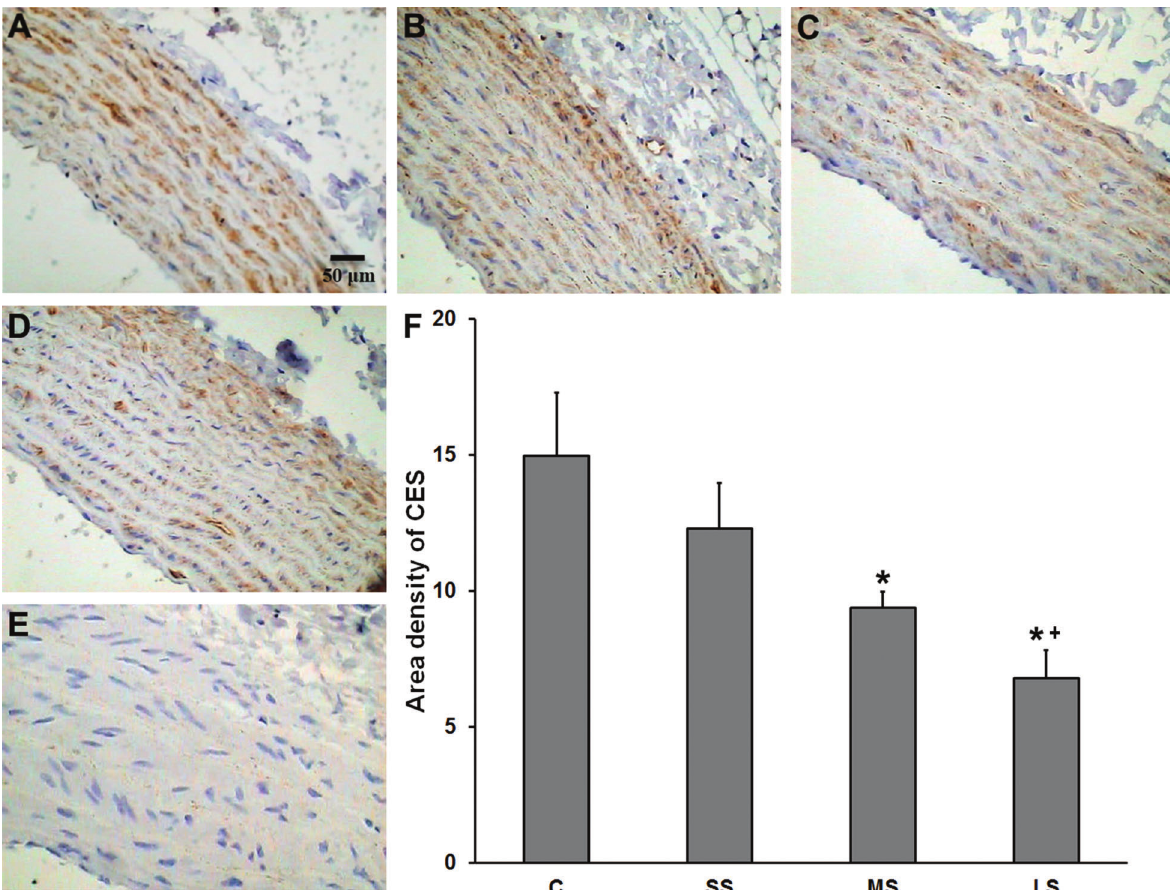
Figure 2. Immunohistochemical staining of cystathionine g -lyase (CSE) expression. A , Control (C); B, short-term smoking (SS) group; C , middle-term smoking (MS); D , long-term smoking (LS) groups; E , negative control ( (cid:1) 400); F , quanti fi cation of the staining. Data are reported as means ± SD. *P o 0.05 compared with C group; + P o 0.05 compared with SS group